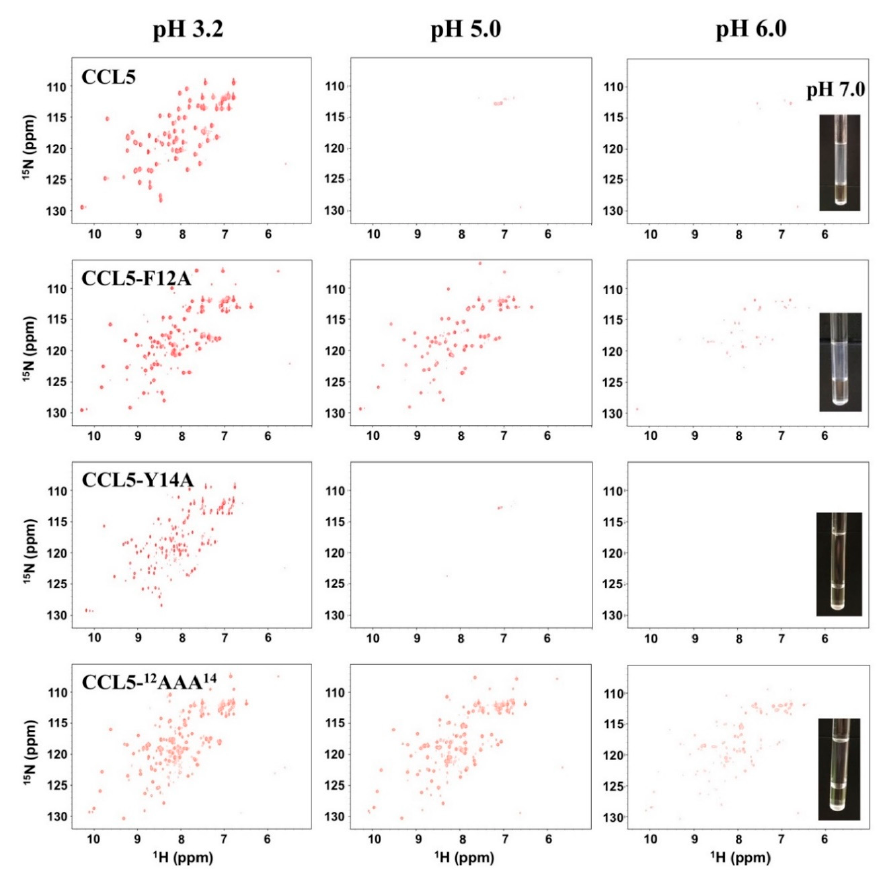
Figure 1. Comparison of the 1 H, 15 N-HSQC spectra of human CC-type chemokine ligand 5 (CCL5), CCL5-F12A, CCL5-Y14A, and CCL5- 12 AAA 14 under different pH values. All samples were prepared with a concentration of 0.2 mM in 25 mM sodium acetate and 150 mM sodium chloride. The HSQCs were performed at 298 K. The images of NMR samples at pH 7.0 show different tendencies in protein aggregation and precipitation.